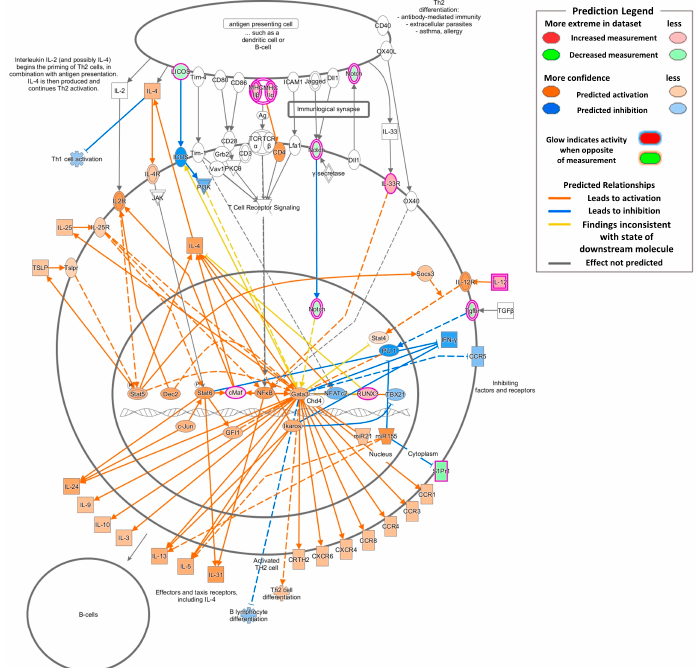
Figure 5. Kathon-activated T helper cell type-2 (Th2) pathways. Pathway image generated by IPA core analysis illustrating gene expression and potential outcomes associated with the Th2 pathway. Color intensity indicates the degree of upregulation (red) or downregulation (green) within the pathway and predicted activation (orange) or inhibition (blue). White indicates molecules present in the dataset but that did meet the cutoff values (false discovery rate ≤ 0.05 and a log2-fold change of either ≥ 1 or ≤− 1). Table 3. Genes altered in the Th2-related signaling pathways.